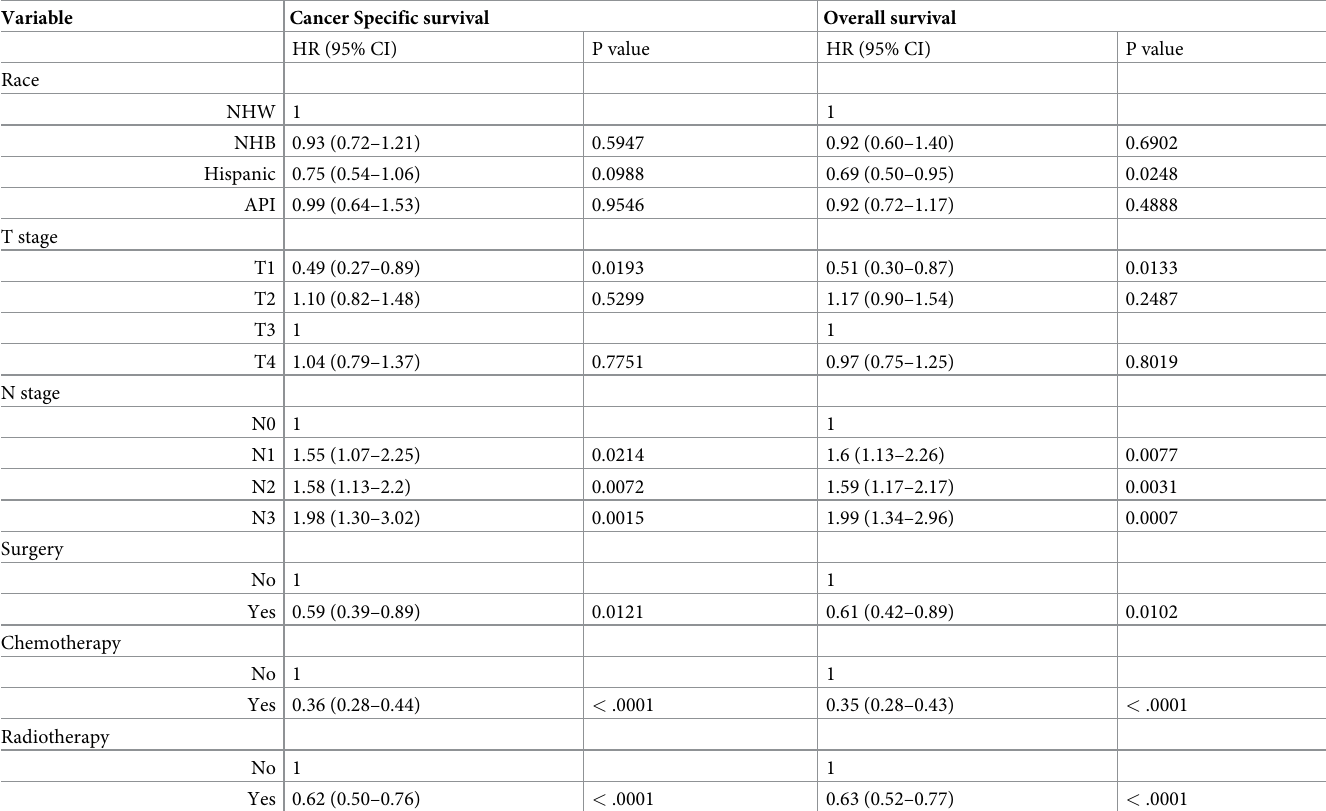
Table 7. Multivariate analysis of factors associated survival in patients with distant metastatic hypopharyngeal squamous cell carcinoma.